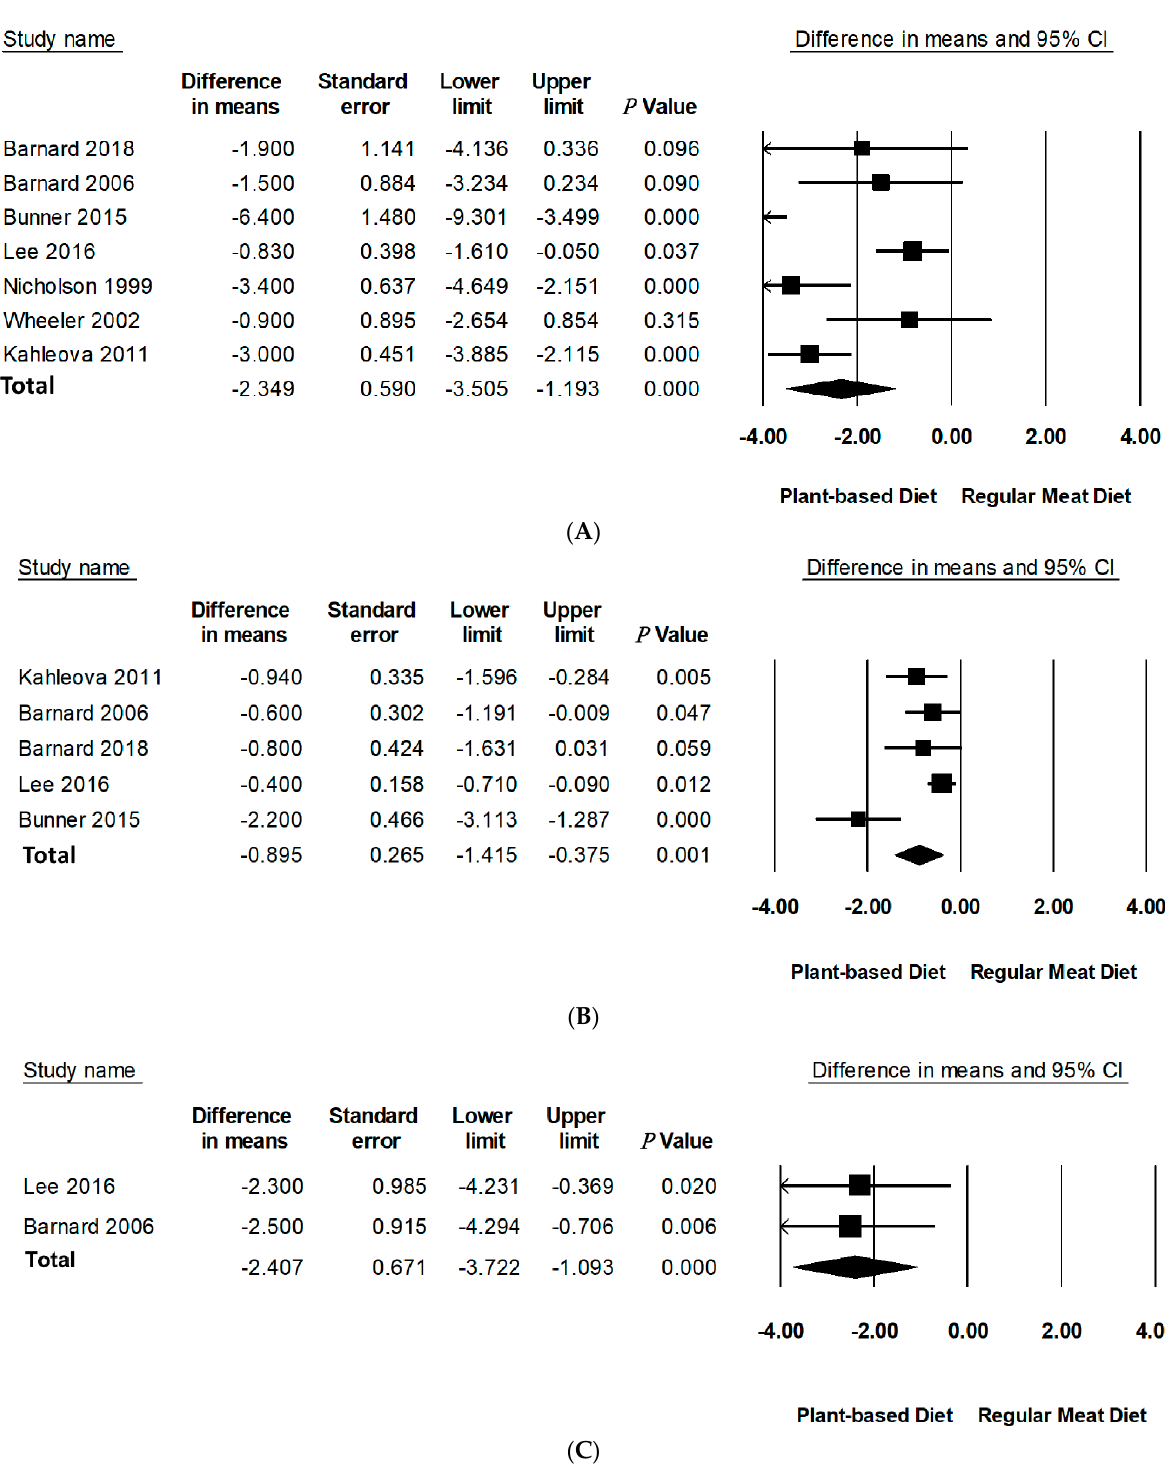
Figure 2. Forest plots displaying difference in means (MD) and 95%Cls for the effect of PBDs compared to RMDs on ( A ) body weight (kg) [30–36], ( B ) BMI (kg/m 2 ) [29,30,32–34], and ( C ) waist circumference (cm) [32,34].